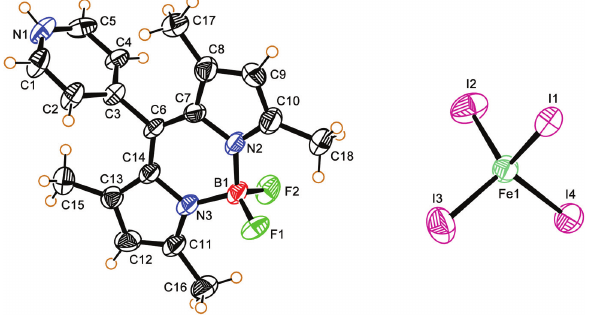
Table 1: Data collection and handling.